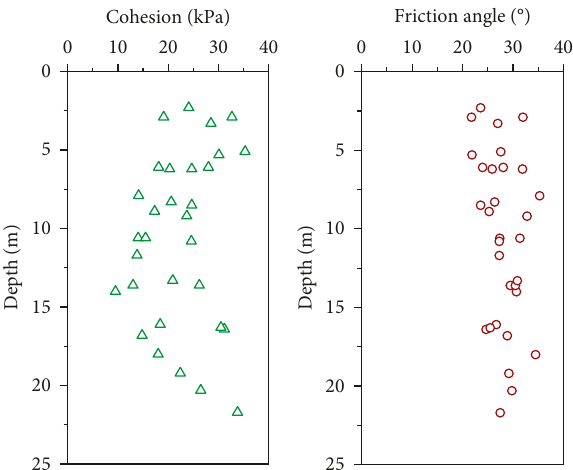
Figure 4: Relationships between the quick direct shear box test results and the